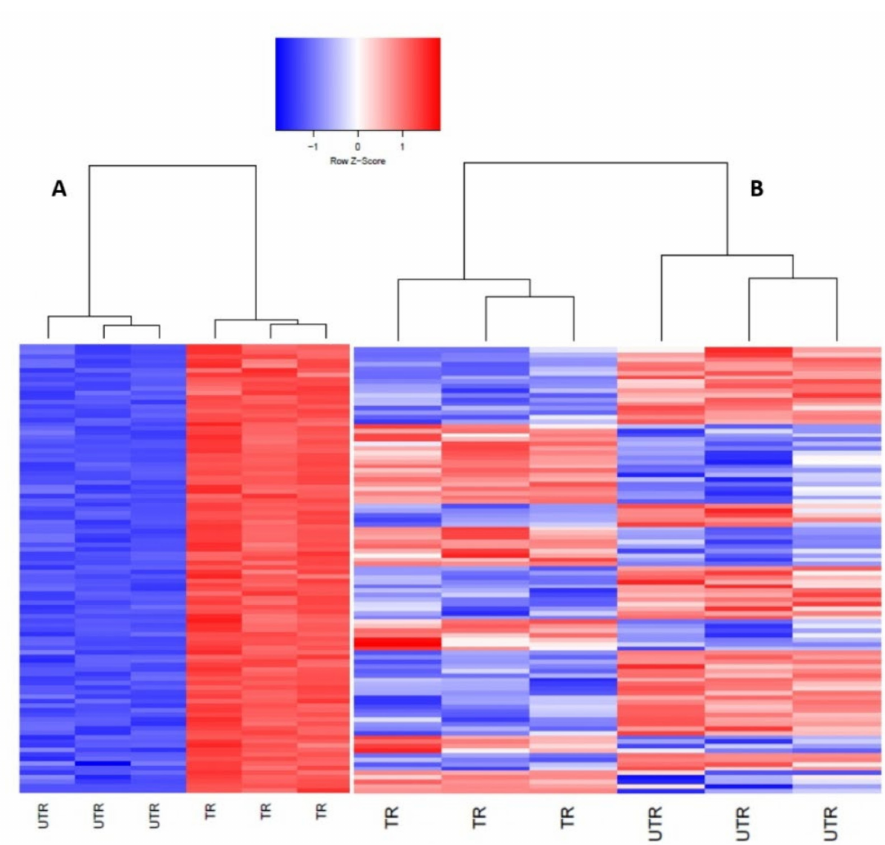
Figure 4. Hierarchically clustered heatmap of the top 100 genes that were differentially expressed in the PDCoV-infected HIEC cells (humans) ( A ) and the PDCoV-infected IPEC cells (pigs) ( B ) at 24 hpi compared to the non-infected cells ( p < 0.05). Each line above represents grouping of samples at different levels. Up-regulated genes were represented in red, and down-regulated genes were represented in blue. UTR, non-infected cells; TR, infected